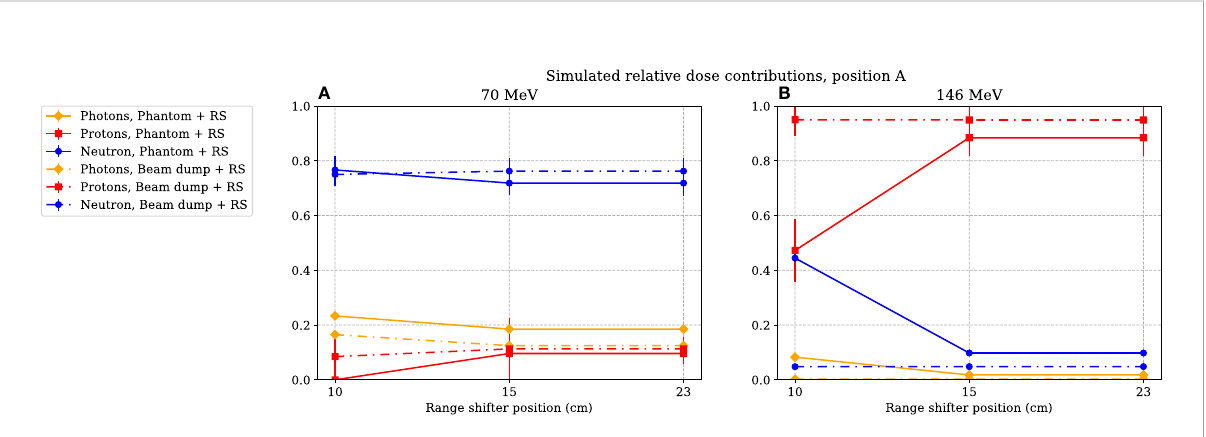
FIGURE 9 The simulated relative dose contribution at position A when the phantom or proton beam dump was irradiated with 70- and 146-MeV protons (A) and (B) respectively. The range-shifter positions correspond to the air gaps when the phantom was present. The lines between data points are used as guide for the eye. The dashed – dotted lines show the simulated relative dose contribution when no phantom was present, while the solid lines show the contributions when the phantom was irradiated. The values are illustrated with one standard